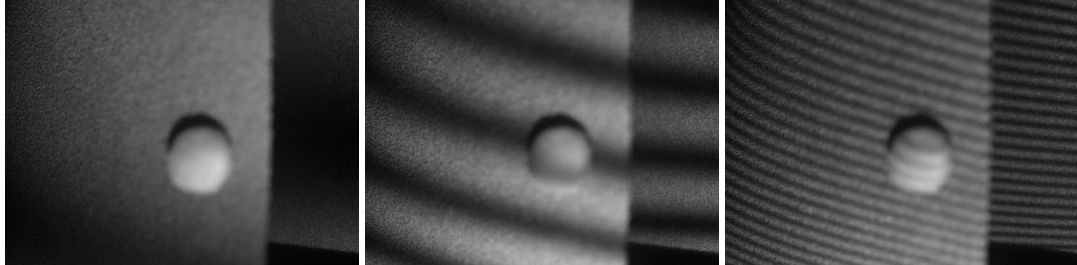
Figure 4. Example sequence of fringe patterns. Three frequencies (waves per pattern) are used: 1, 6, 36. Only one pattern per frequency is